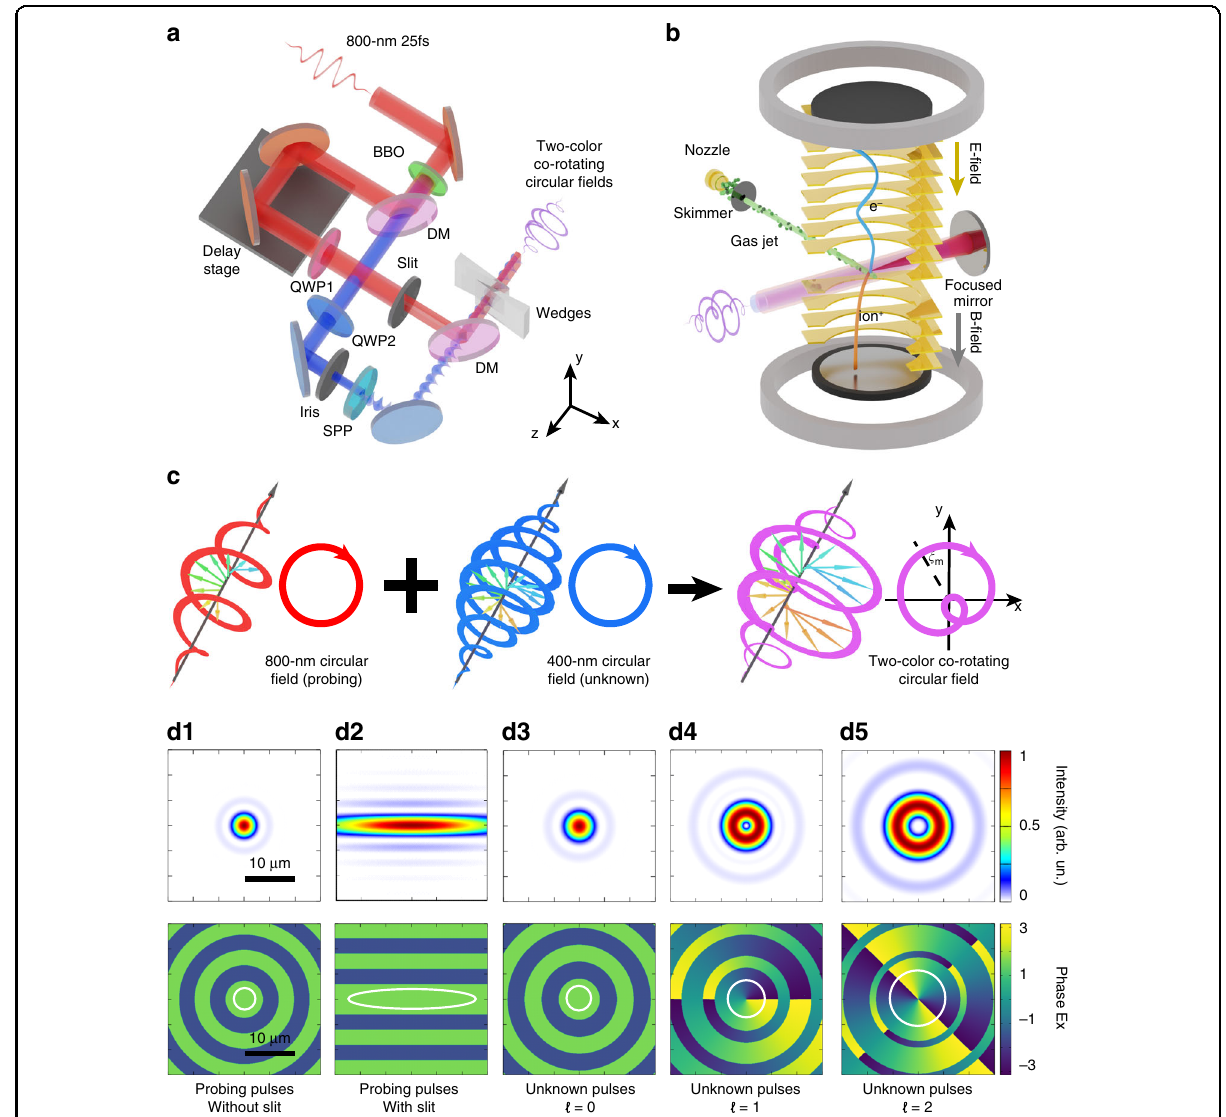
Fig. 1 Schematic of the experiment. a Layout showing the preparation of the two-color co-rotating circular light fi elds with the 800-nm light pulses (red) and 400-nm light pulses (blue). A Mach – Zehnder interferometer scheme is used. BBO, barium borate crystal; DM, dichroic mirror; QWP, quarter-wave plate; SPP, spiral phase plate. b Illustration of the strong- fi eld ionization detection experiment. The generated two-color co-rotating circular fi eld interacts with the supersonic argon atom gas jet inside of COLTRIMS apparatus. c Diagram of the electric fi eld vectors of the 800-nm circular fi eld (red), 400-nm circular fi eld (blue), and two-color co-rotating circular fi eld (purple), respectively. For each laser fi eld, a 3D polarization pro fi le (left) and a 2D Lissajous fi gure of its electric fi eld in transverse plane (right) are given. The de fl ected angle of peak electric fi eld of the two-color fi eld, ξ – d5 The simulated light spatial pro fi les in the focal plane. The top panels show the normalized intensity m , is related with that in Fig. 2a. d1 distributions and the bottom panels show the phase structure of x -component electric fi eld. The white circles enclose the regions (exclude the singularities in b4 and b5), where the light intensity is larger than 0.5 I m ( I m , the peak intensity of focal light fi